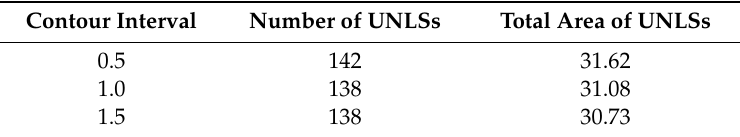
Table 7. Impact of the contour interval on the detection of